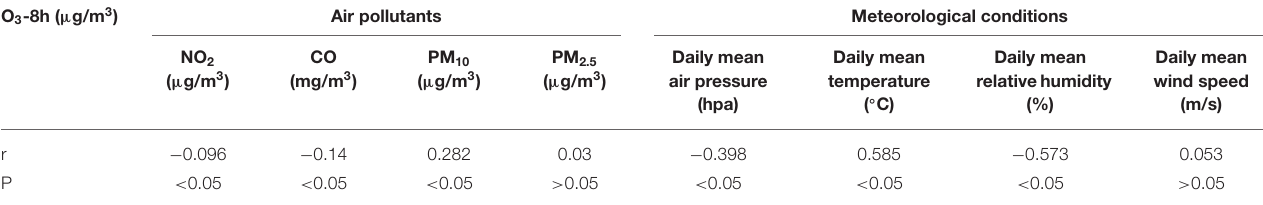
TABLE 2 | Correlation analysis of air pollutants and meteorological indicators in Nanchang